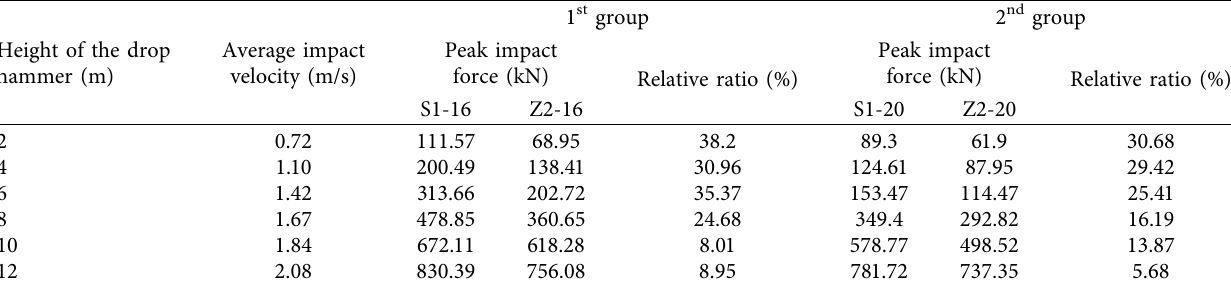
Figure 10: Time history curve of the impact forces when the drop hammer was lifted to 4m and 10m, respectively. In the figure, diameter 16 is 50mm closed-cell aluminum foam, and diameter 20 is 100 mm closed-cell aluminum foam. Table 6: Impact force test results and